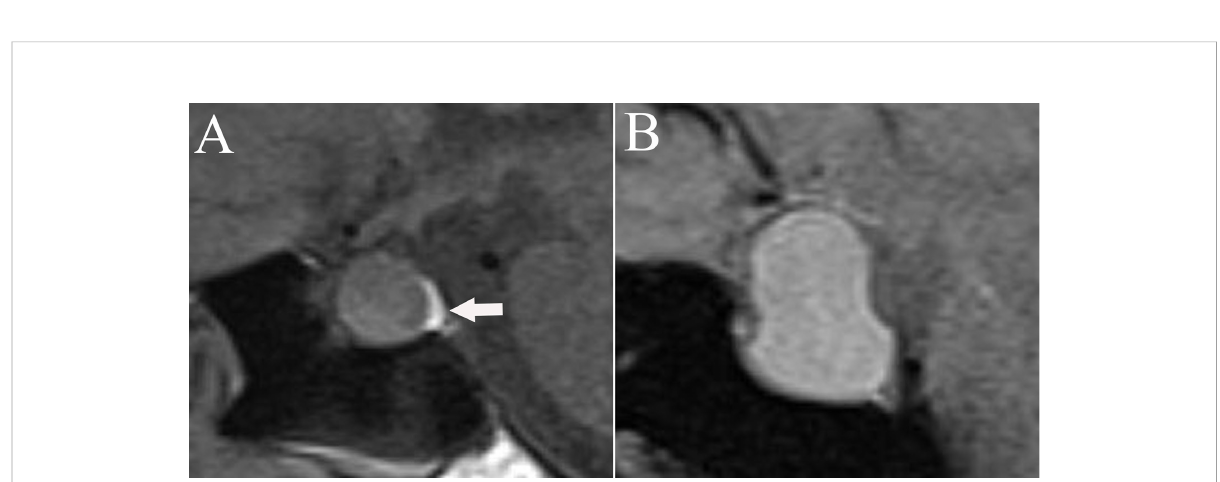
FIGURE 2 The appearance and location of posterior pituitary bright spots (white arrow) on T1-weighted images. (A) Posterior pituitary bright spots locates under the diaphragma sellae. (B) Posterior pituitary bright spots is